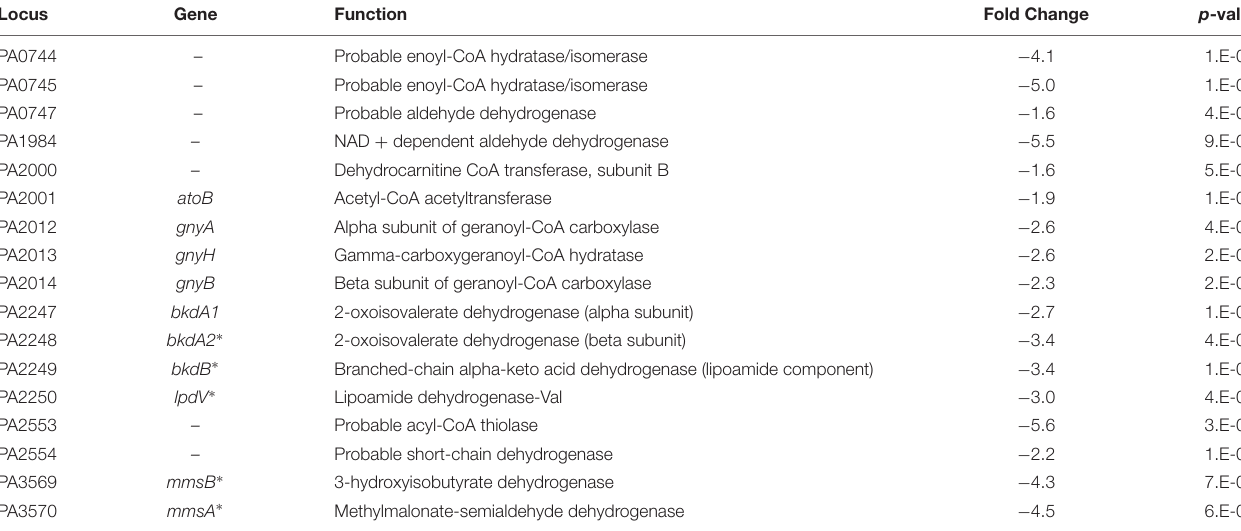
TABLE 2C | Down-regulated genes involved in branched chain amino acid catabolism.